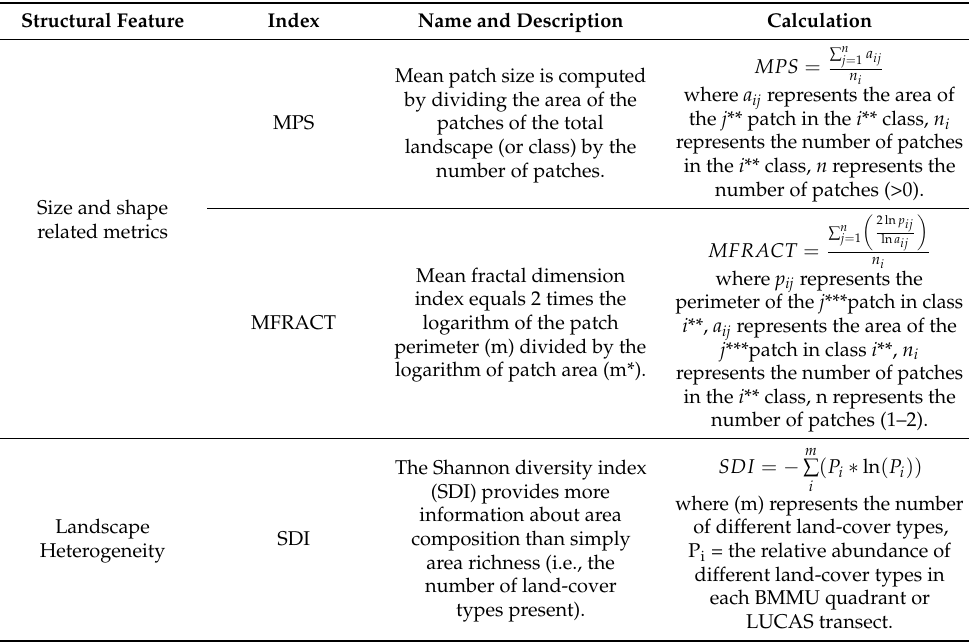
Table 1. Descriptions and calculations of the applied landscape indices